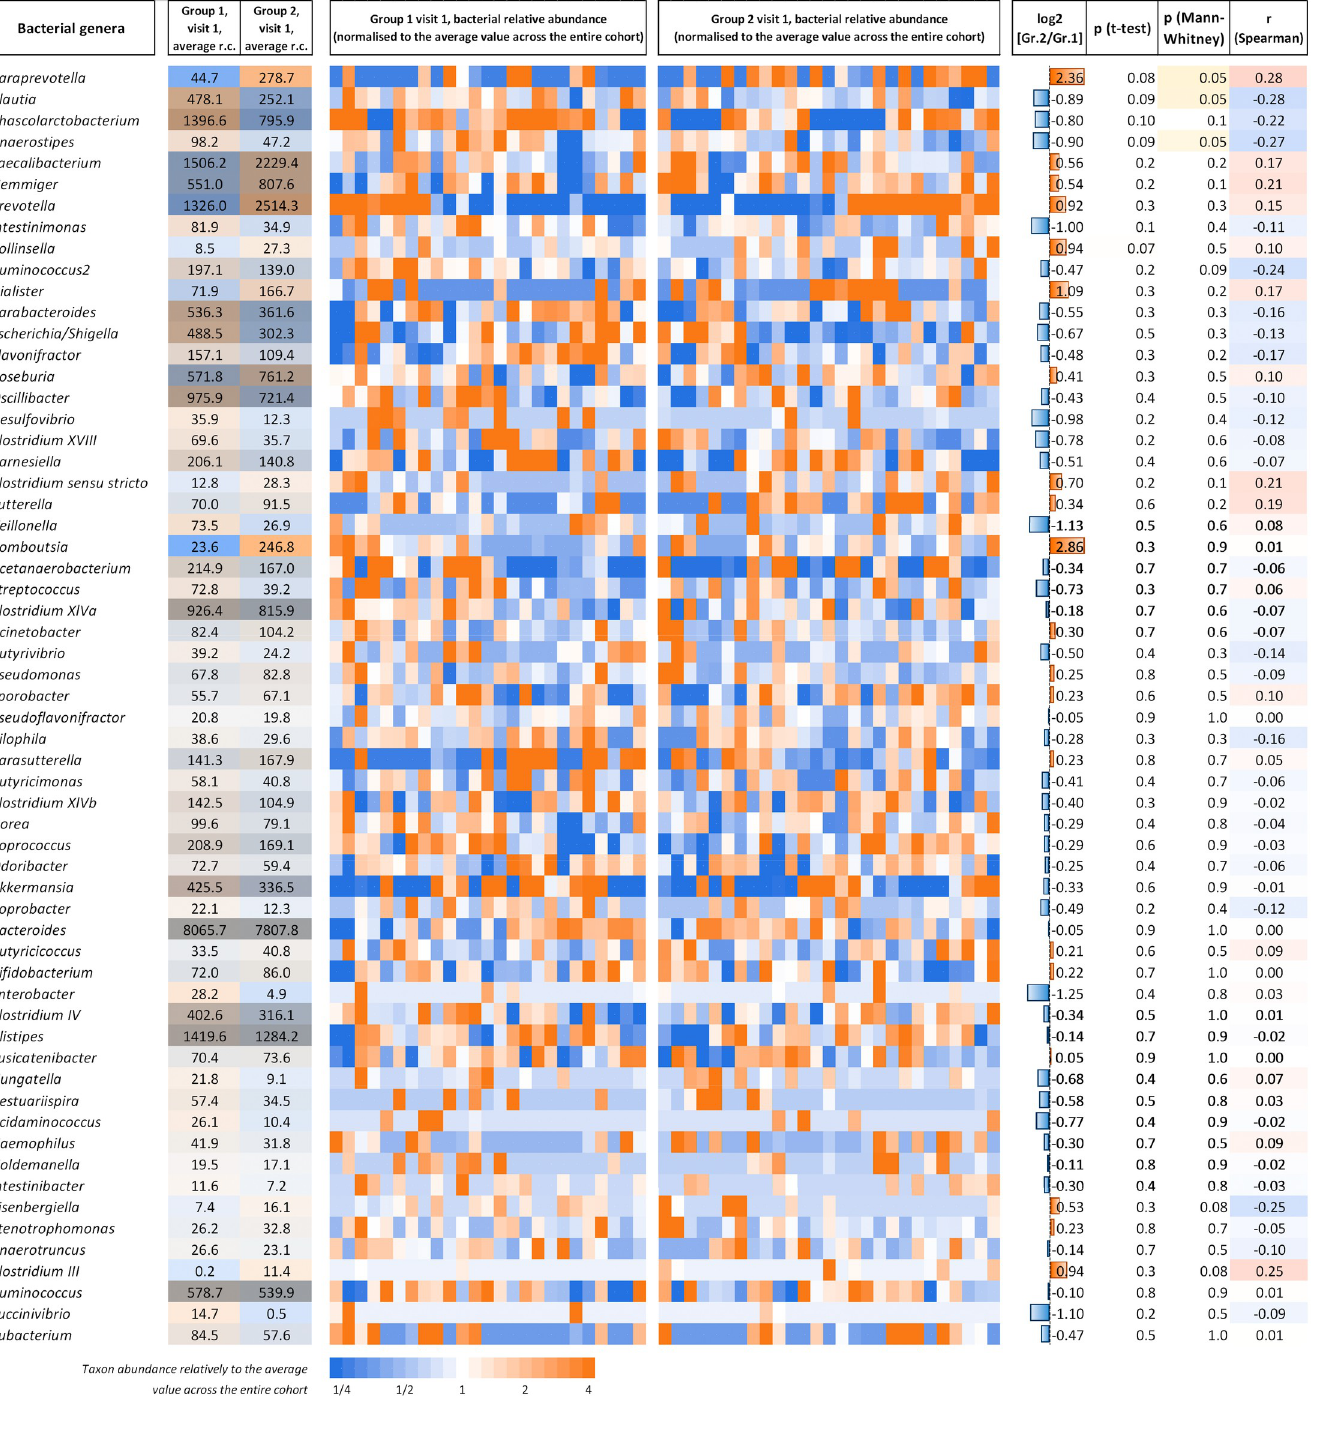
PLOS ONE | https://doi.org/10.1371/journal.pone.0263880 June 15,